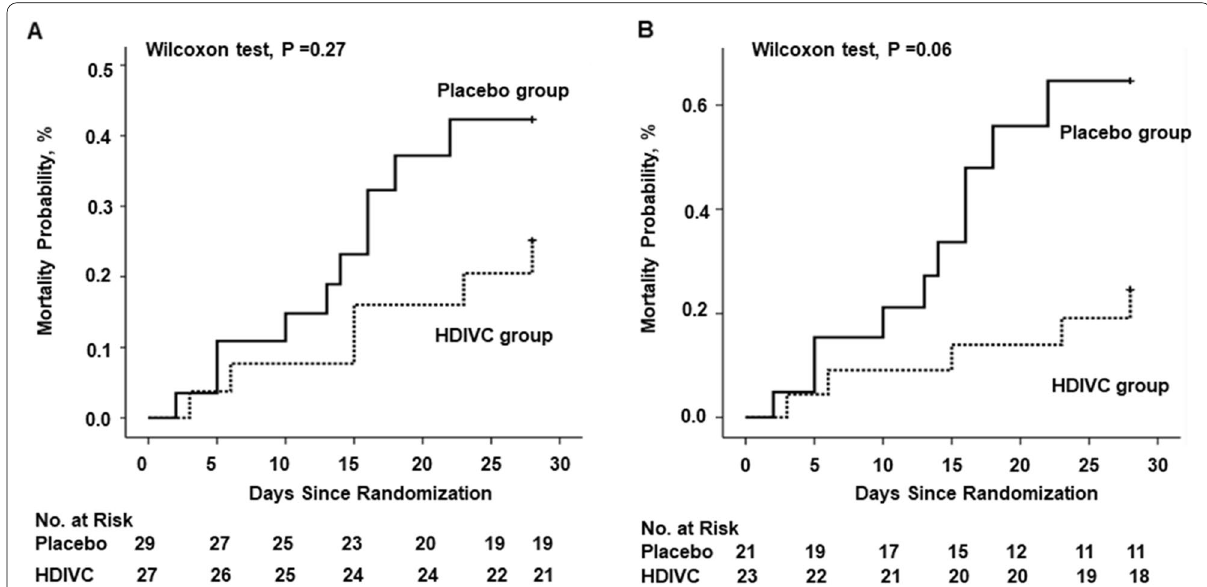
Fig. 3 The 28-day mortality from randomization (day 1) to day 28. a Kaplan–Meier analysis was used to estimate the 28-day mortality, and survival curves were compared with the Wilcoxon test ( P 0.27) among patients with COVID-19. Cox regression was used for multiple comparisons = ( P 0.31, HR, 0.50 [95% CI 0.2 to 1.8]). b Kaplan–Meier analysis was used to estimate the 28-day mortality and survival curves were compared with = the Wilcoxon test ( P 0.06) among severe COVID-19 patients (baseline SOFA score 3). Cox regression was used as multiple comparisons ( P = ≥ HR, 0.32 [95% CI 0.10–1.06]). HDIVC high-dose intravenous vitamin C, COVID-19 coronavirus disease 2019, SOFA Sequential Organ Failure